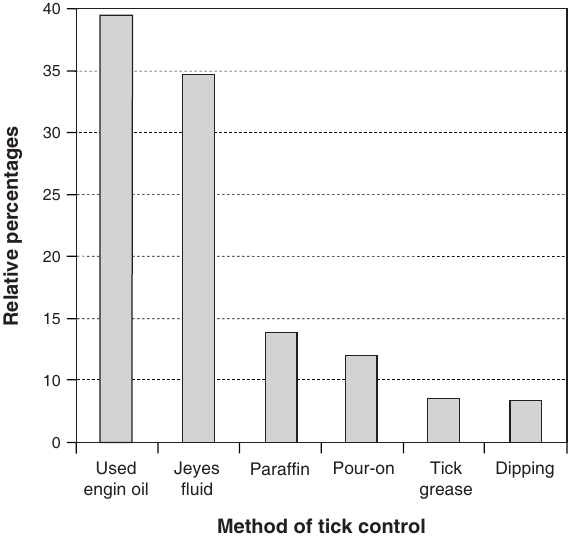
FIG. 1 Results of a questionnaire survey on tick control meas- ures used by resource-poor farmers in communal land areas of Qwa-Qwa between February and April